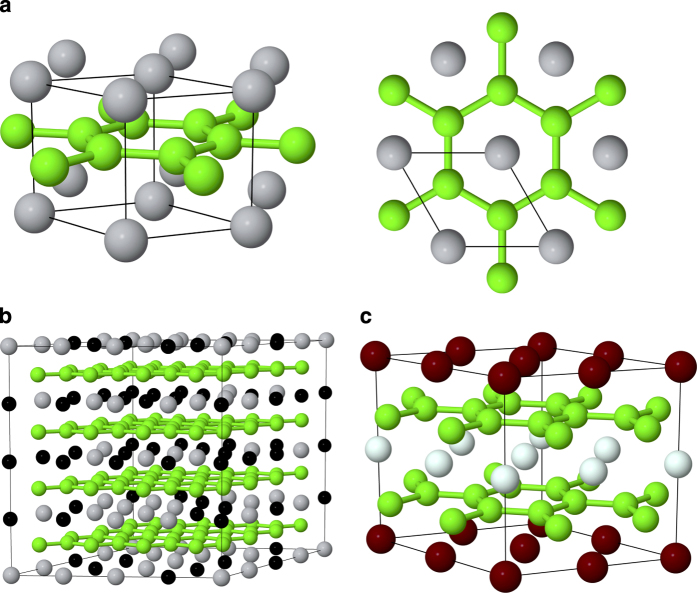
a) Side and top-view of the AlB2 crystal structure, b) a 192 atoms SQS supercell used for modeling e.g. Al0.5Ti0.5B2, c) the layered ordered alloy structure found to be lowest in energy for, e.g., ScVB4.